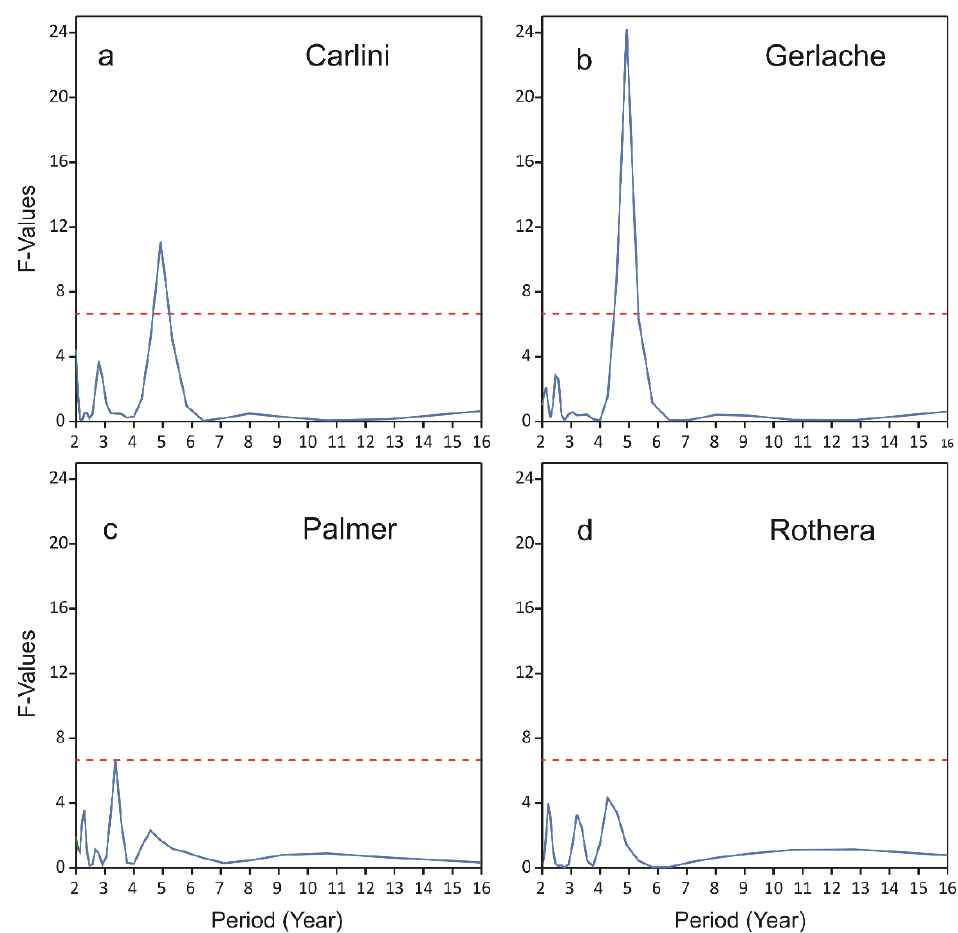
Figure 5. Power spectra derived by the periodogram method for the time series of standardized SST anomalies at ( a ) Carlini, ( b ) Gerlache, ( c ) Palmer, and ( d ) Rothera sites. The dashed red line represents the critical F value (Fcrit) at an alpha error of 5%; Fcrit = 6.66 in all cases.